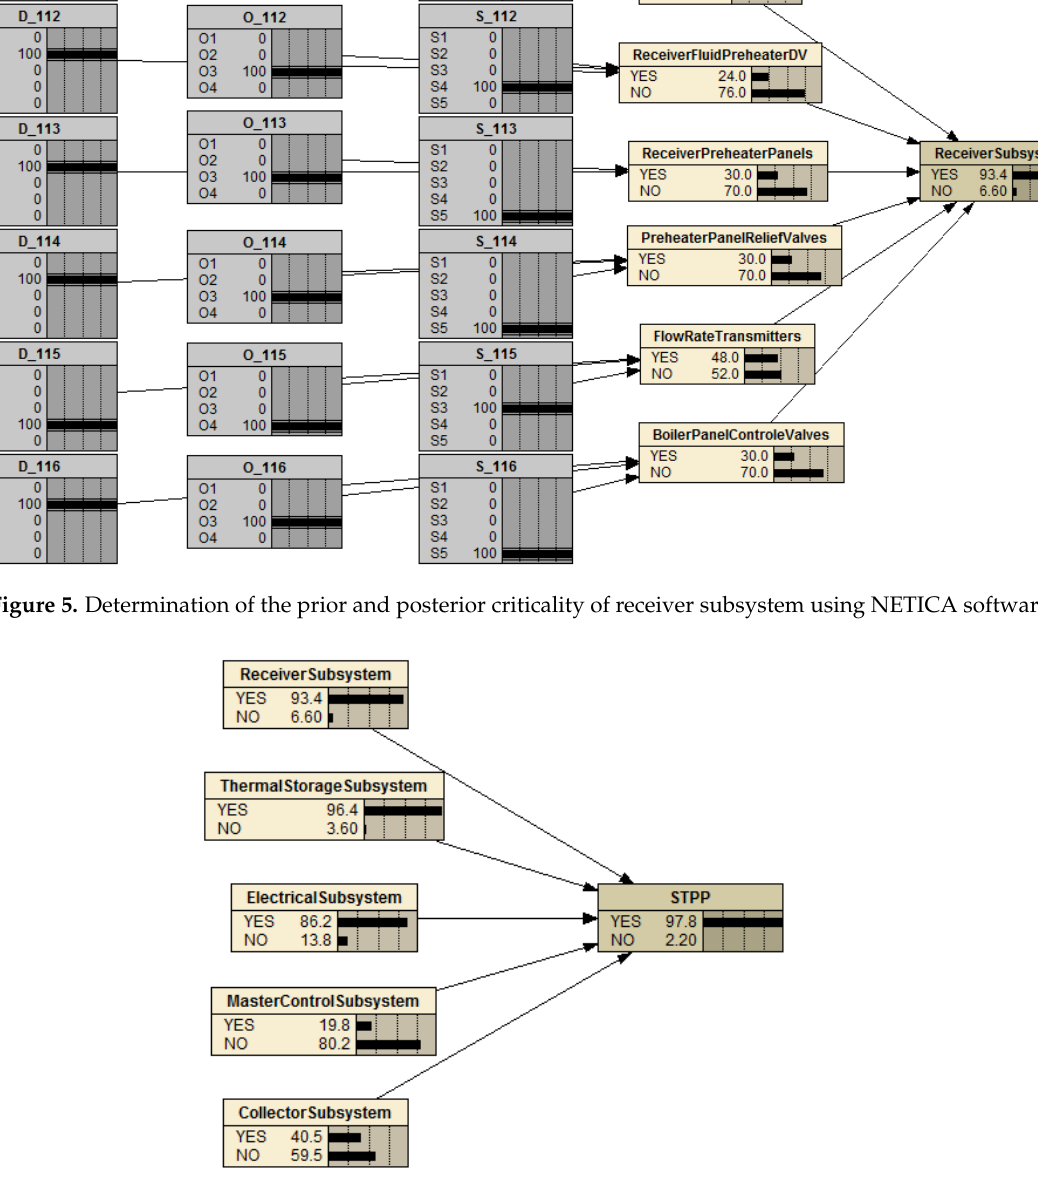
Figure 6. Determination of the posterior criticality of the STPP using NETICA software.